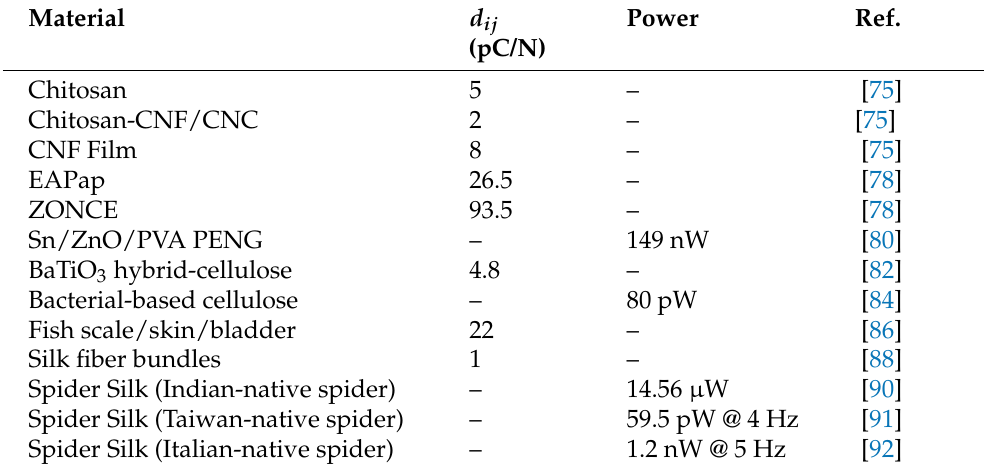
Figure 2. ( a ) Schematic view of electromechanical converter based on spider silk as active element and Al electrodes. ( b ) Voltage response and maximum power output at resonance frequency. Data from [92]. Table 3. Comparison of piezoelectric coefficient and output power for organic